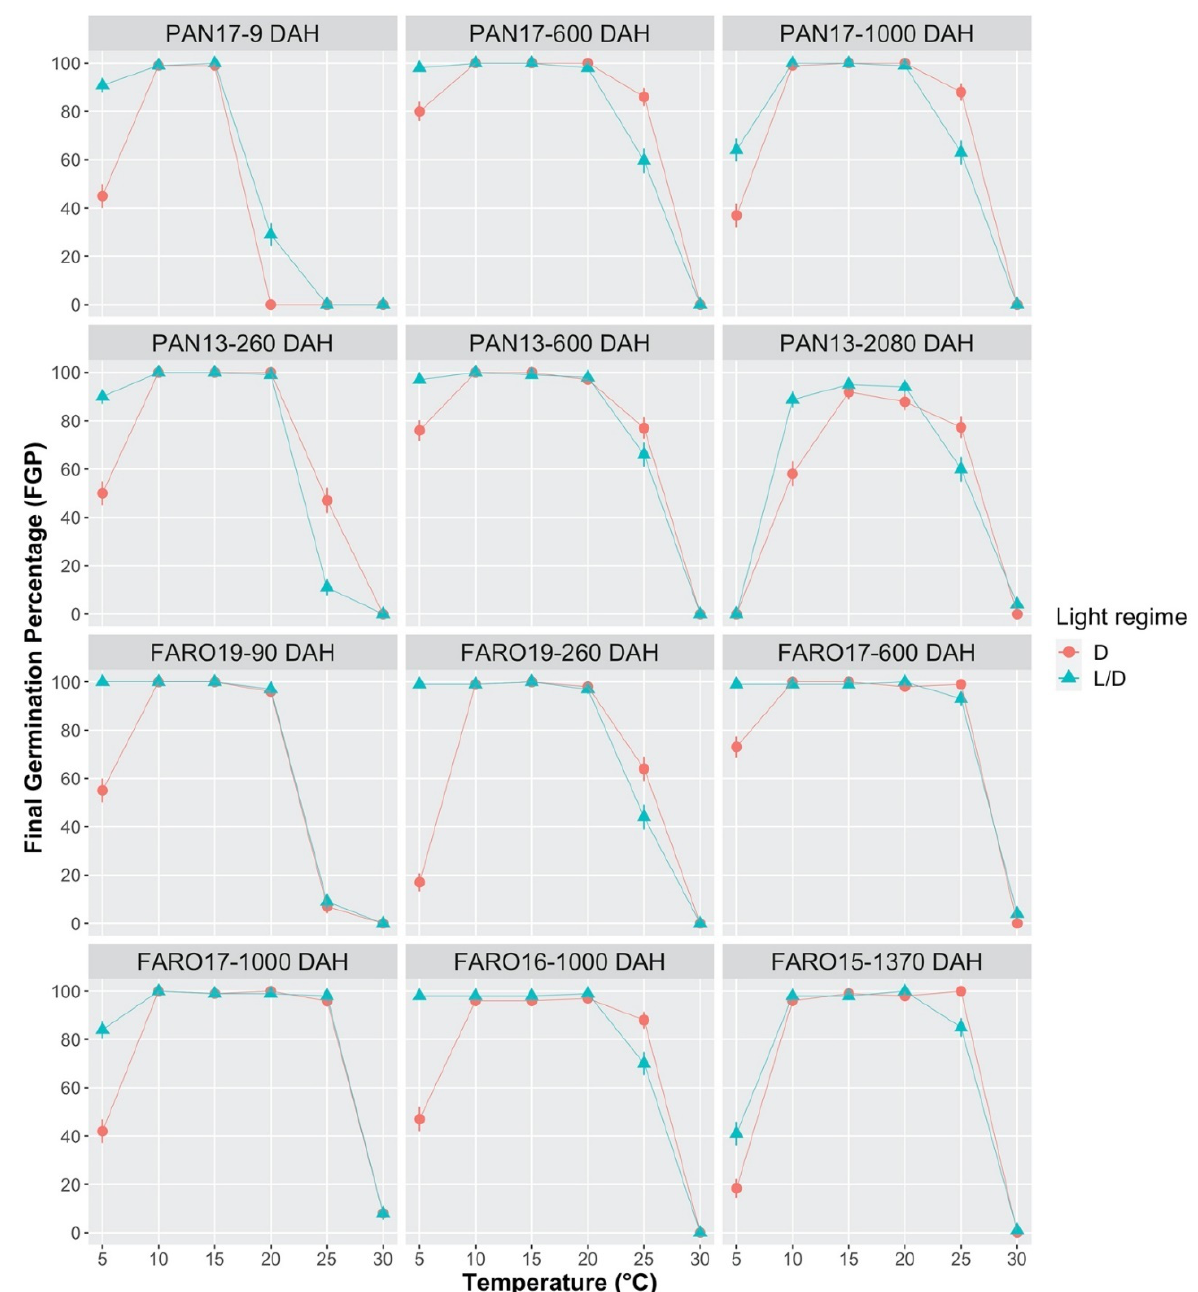
Figure 2. Effect of constant temperature regimes (from 5 ◦ C to 30 ◦ C) on the final germination percentage (FGP) of S. hicesiae , at seven different seed ages (9, 90, 260, 600, 1000, 1370, and 2080 days after harvest = DAH), under Light/Dark (L/D 12/12 h) and continuous Darkness (D 24 h) conditions. Seeds were collected across five years (2013, 2015, 2016, 2017, 2019) from two seed sources (PAN and FARO).